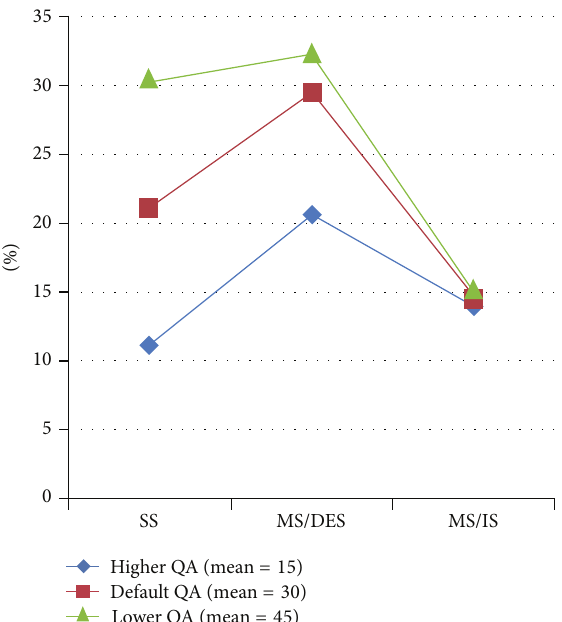
Figure 11: Results of Successful Query Ratio for different query loads.